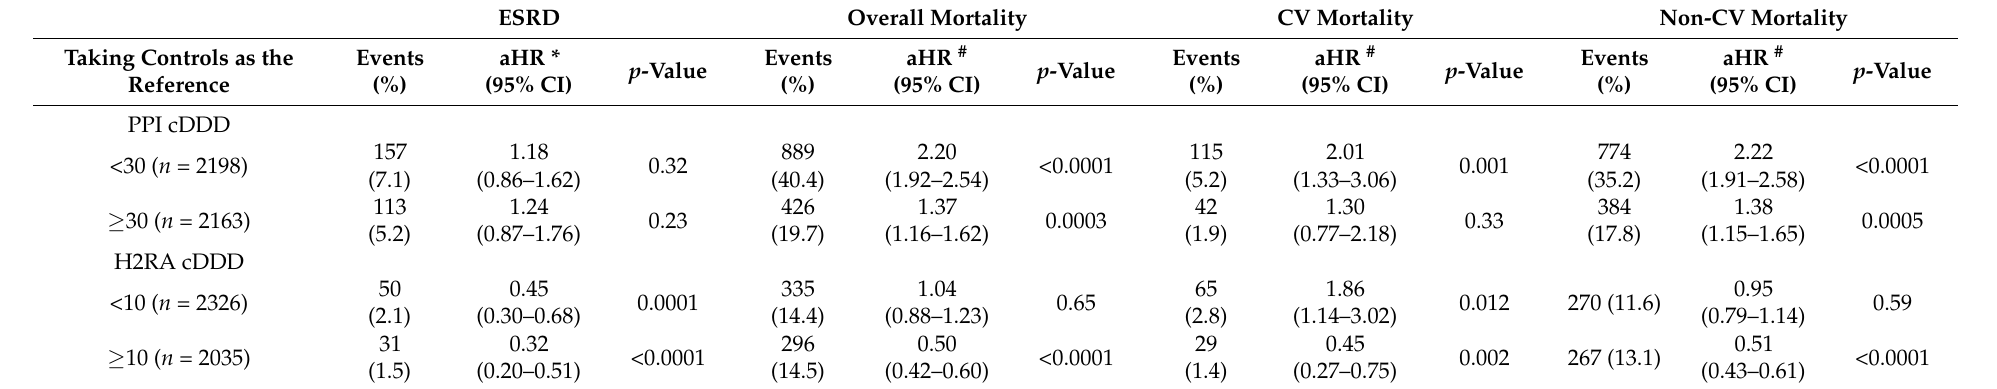
Table 4. Association between median cumulative define daily dose (cDDD) of acid suppressants and study outcomes. ESRD Overall Mortality CV Mortality Non-CV